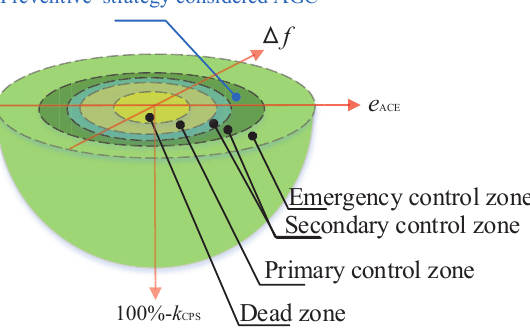
Figure 1. The three gradations of frequency